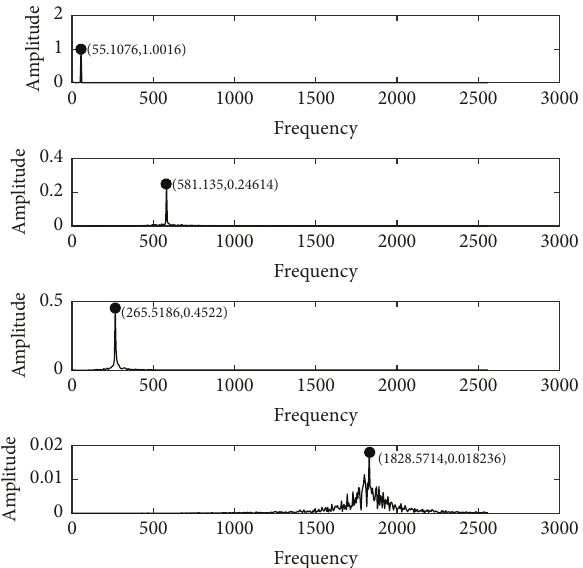
Figure 7: Relevant spectra figures by improved VMD.